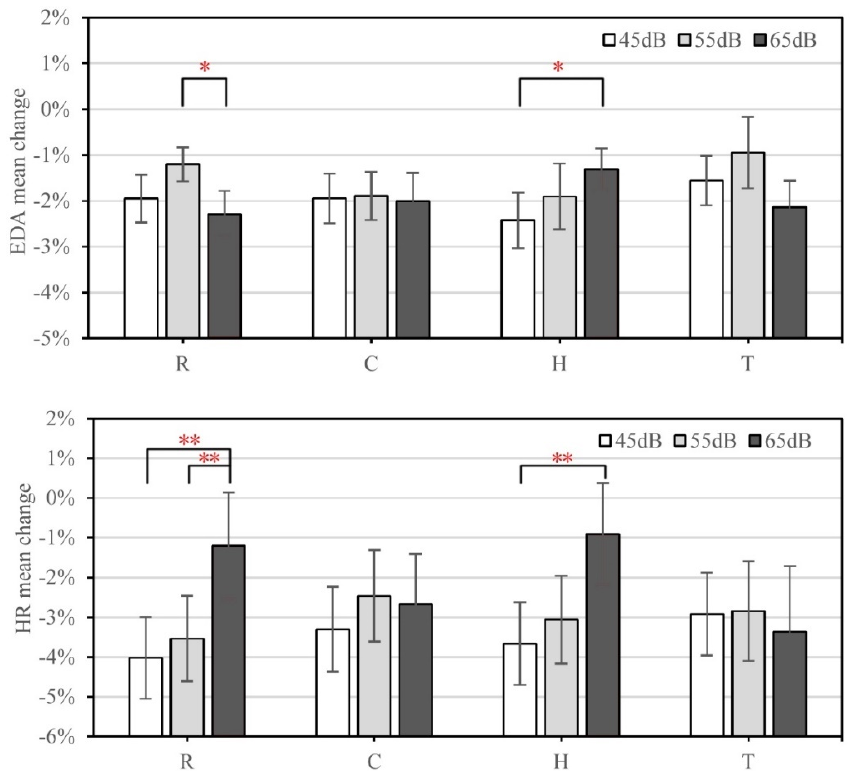
Figure 7. Interaction effect of sound level and sound type on EDA and HR. The vertical bar represents 95% confidence interval. * and ** represent significant differences in the Mann–Whitney U test at a 0.05 level and 0.01 level, respectively.